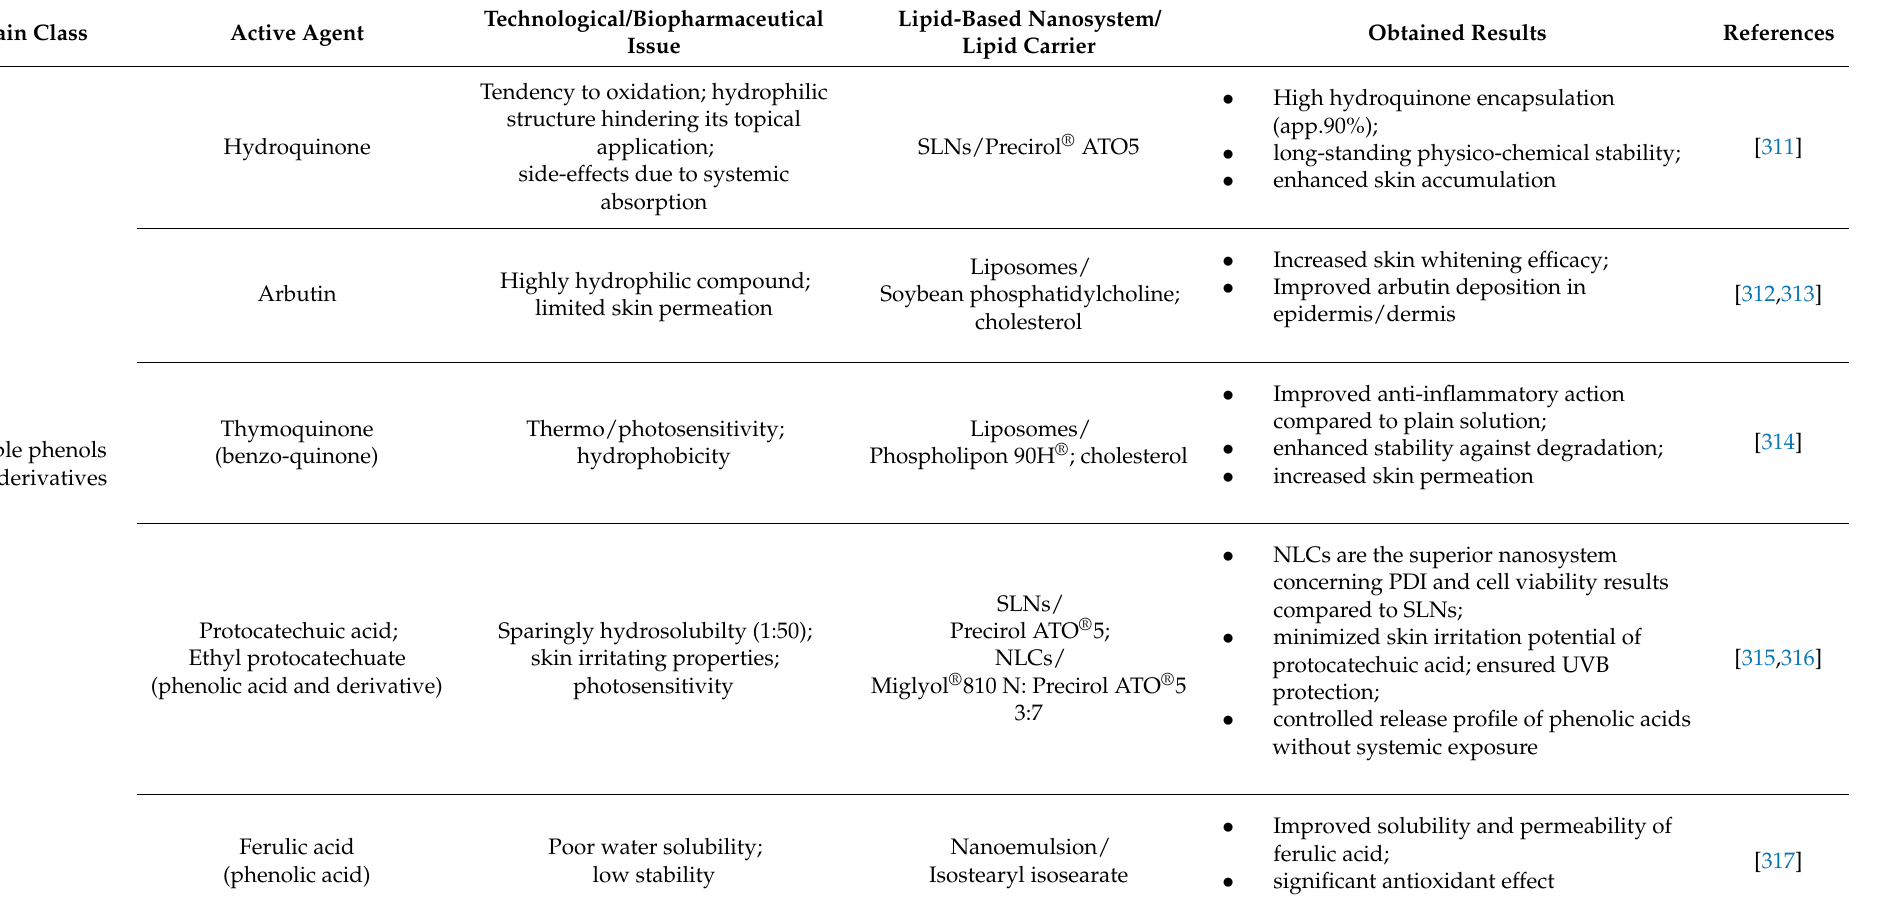
Table 2. Phenolic compounds, encapsulated in lipid-based nanosystems for dermal.